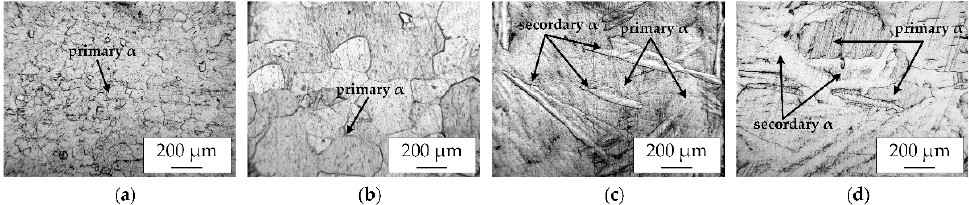
Figure 9. Microstructure of near-surface layer of titanium Grade 2 in initial state ( a ) and after nitriding at 750 °C ( b ) and 900 °C ( c ) and after boriding ( d ).